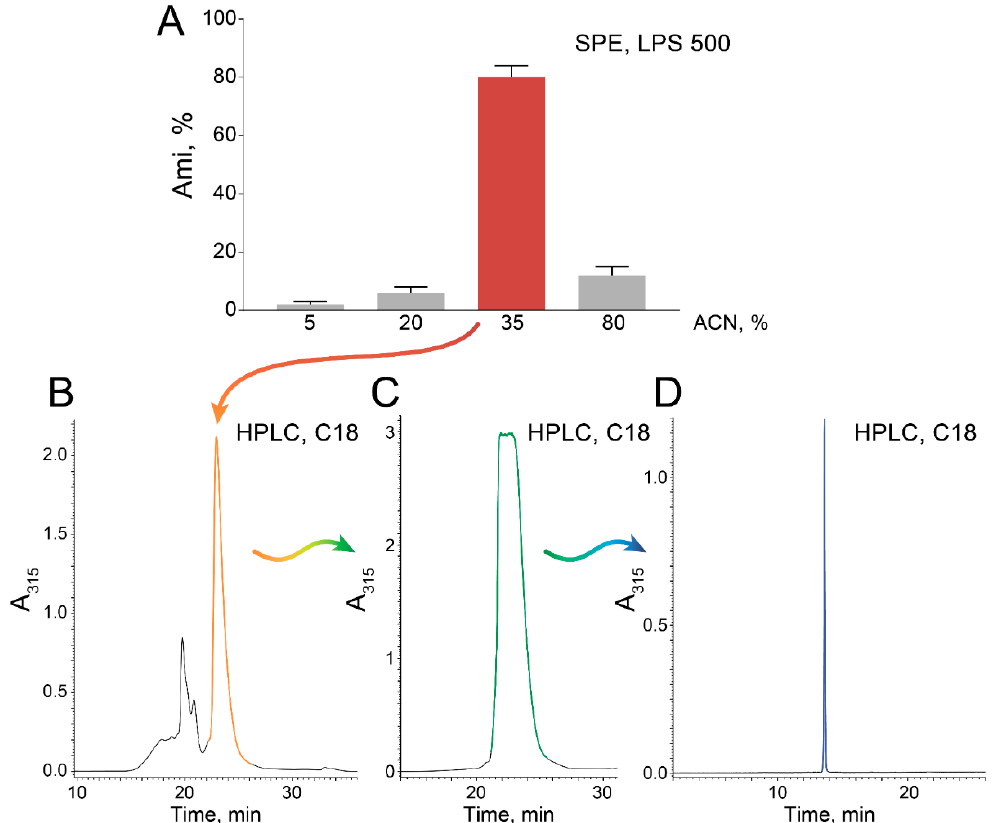
Figure 3. Optimized procedure of Ami purification. ( A ) Solid-phase extraction (SPE) with the polystyrene-based resin LPS 500 (Technosorbent, Russia). The portion of Ami eluted by the corresponding gradient step is indicated. ( B , C ) Sequential purification of Ami-containing fraction using a C18 RP-HPLC column. ( D ) Chromatogram of the purified Ami sample. Ami yield was estimated by an antibacterial activity assay in triplicate. Data represent mean ± SD.